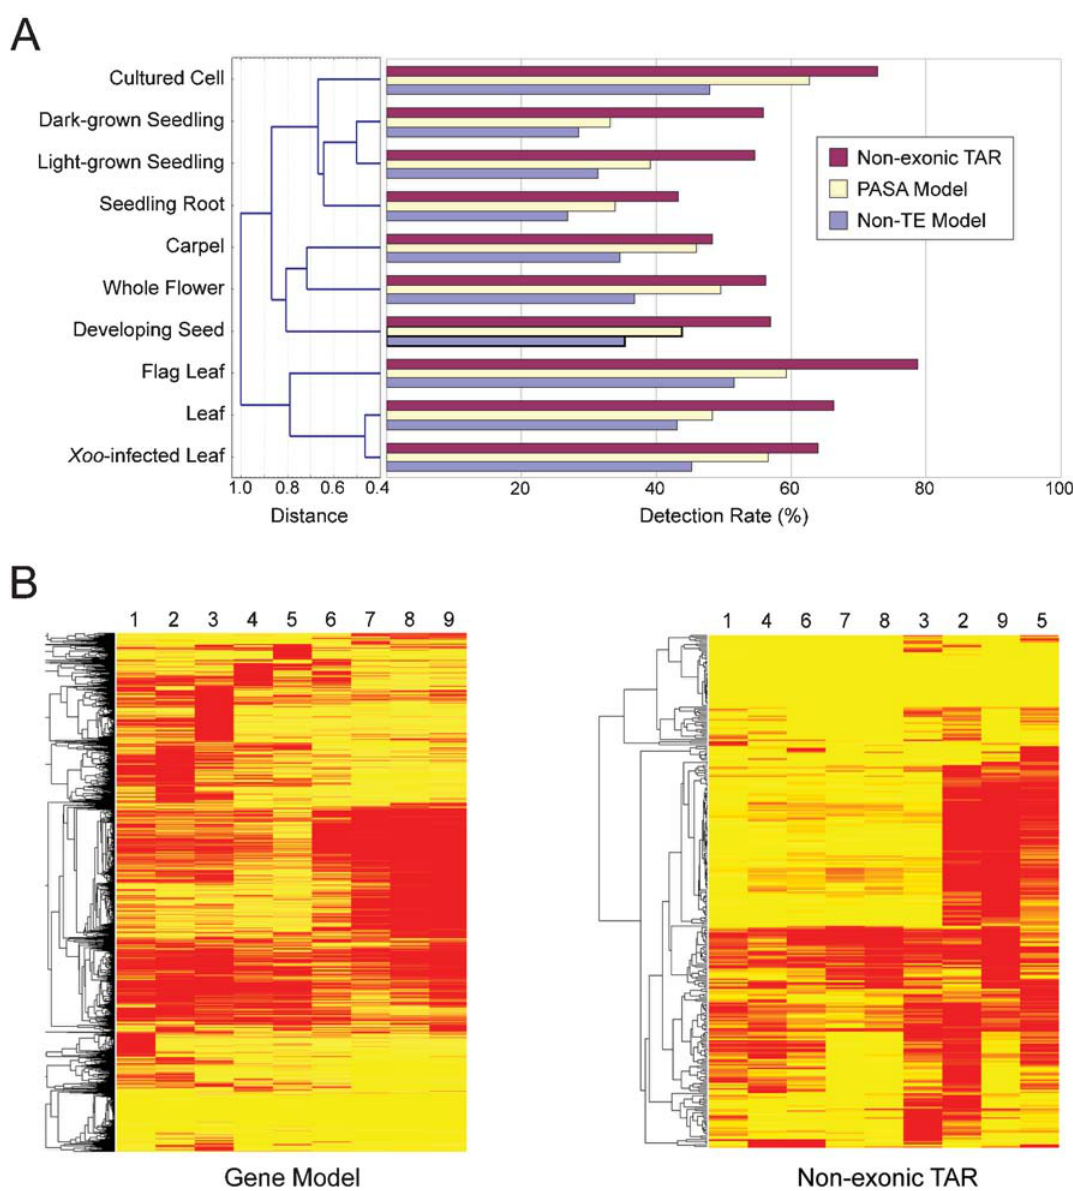
Figure 2. Re-array analysis of japonica gene models and non-exonic TARs. (A) Transcription of gene models and TARs detected by the re-array. Shown on the left is a tree diagram of the overall transcriptional relation of gene models among the 10 assayed tissue types computed with the Manhattan distance function. Expression rates in percentage of all gene models, the PASA gene models, and non-exonic TARs are shown on the right. (B) Heat map of differentially expressed gene models and non-exonic TARs. The red and yellow colors represent up- and down-regulated transcription units, respectively. The gene tree is shown on the left. Numbers on top represent the tissue types: 1, developing seed, 2, carpel, 3, whole flower, 4, dark- grown seedling, 5, seedling root, 6, light-grown seedling, 7, flag leaf, 8, leaf, 9, Xoo -infected